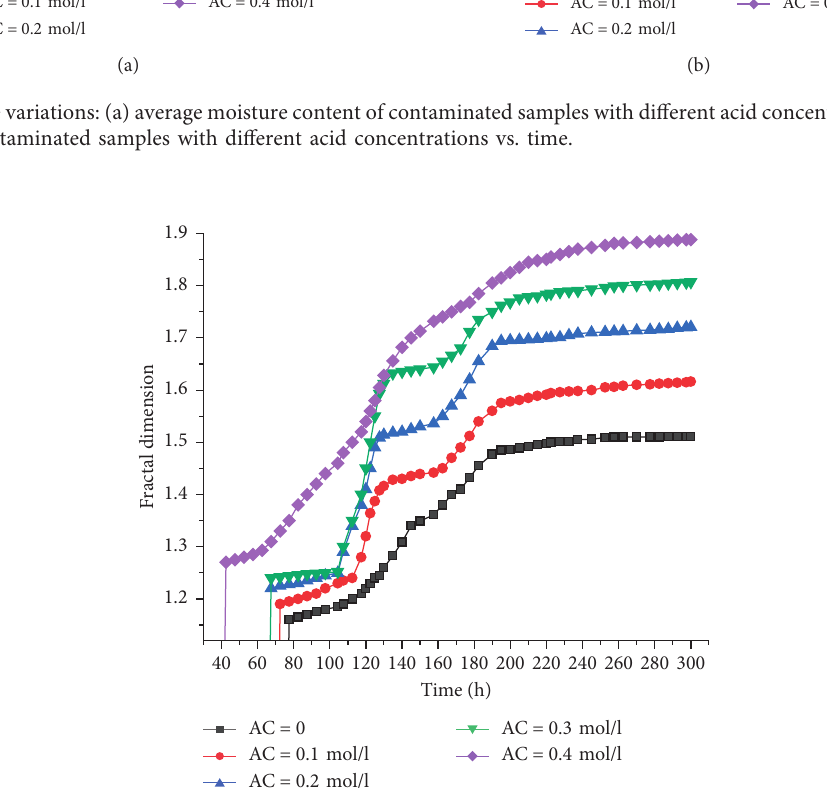
Figure 5: Drying time variations: fractal dimension of cracks in contaminated samples with different acid